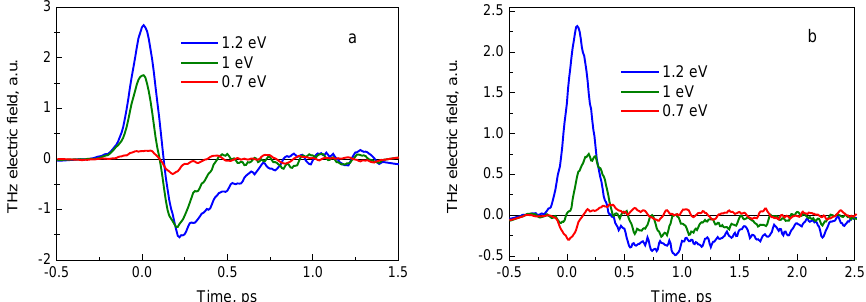
Figure 5. THz electric field pulses calculated by MC method for three different femtosecond optical pulse photon energies. The heterostructure is illuminated from the GaInAsBi layer-side ( a ) or from the InP substrate side ( b ).